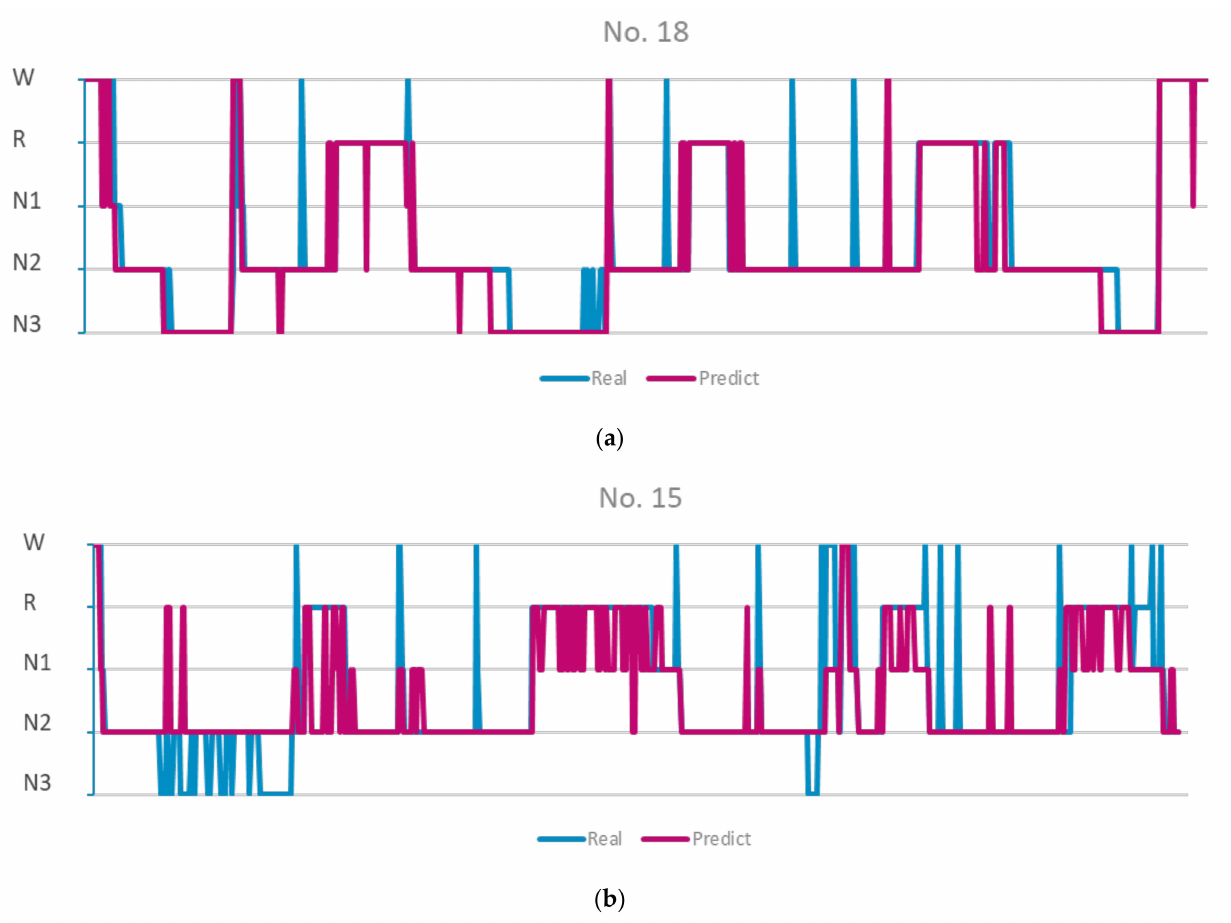
Figure 7. Hypnogram of subjects with or without loss of frequency information in the delta band. ( a ) Record lost information (No. 18). Most of the N3 stages are correctly identified; ( b ) record with lost information (No. 15). While most of the other stages were correctly identified, none of its N3 stages were